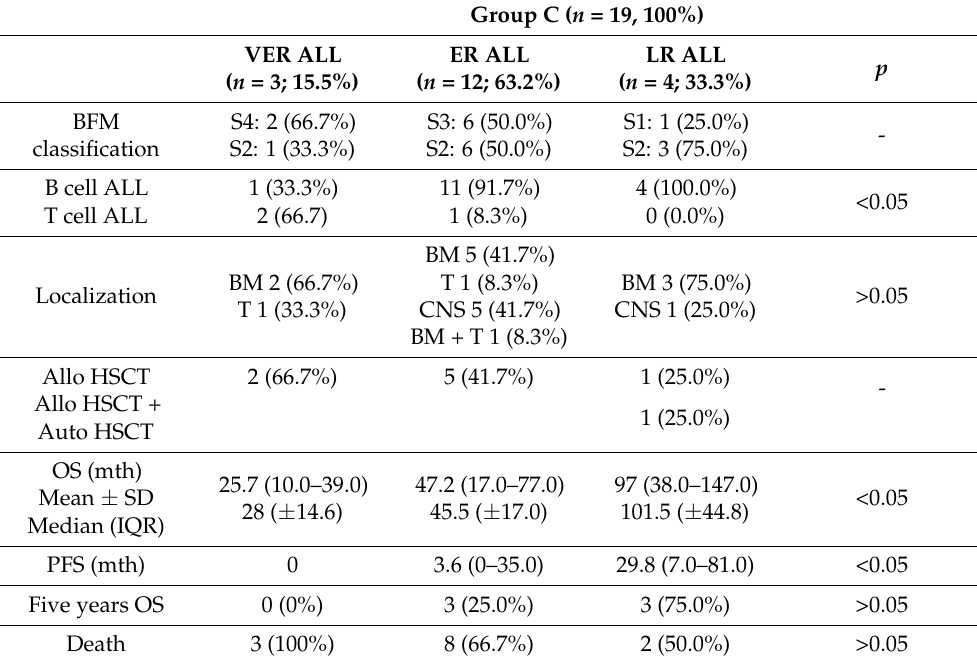
Table 2. Characteristics of group